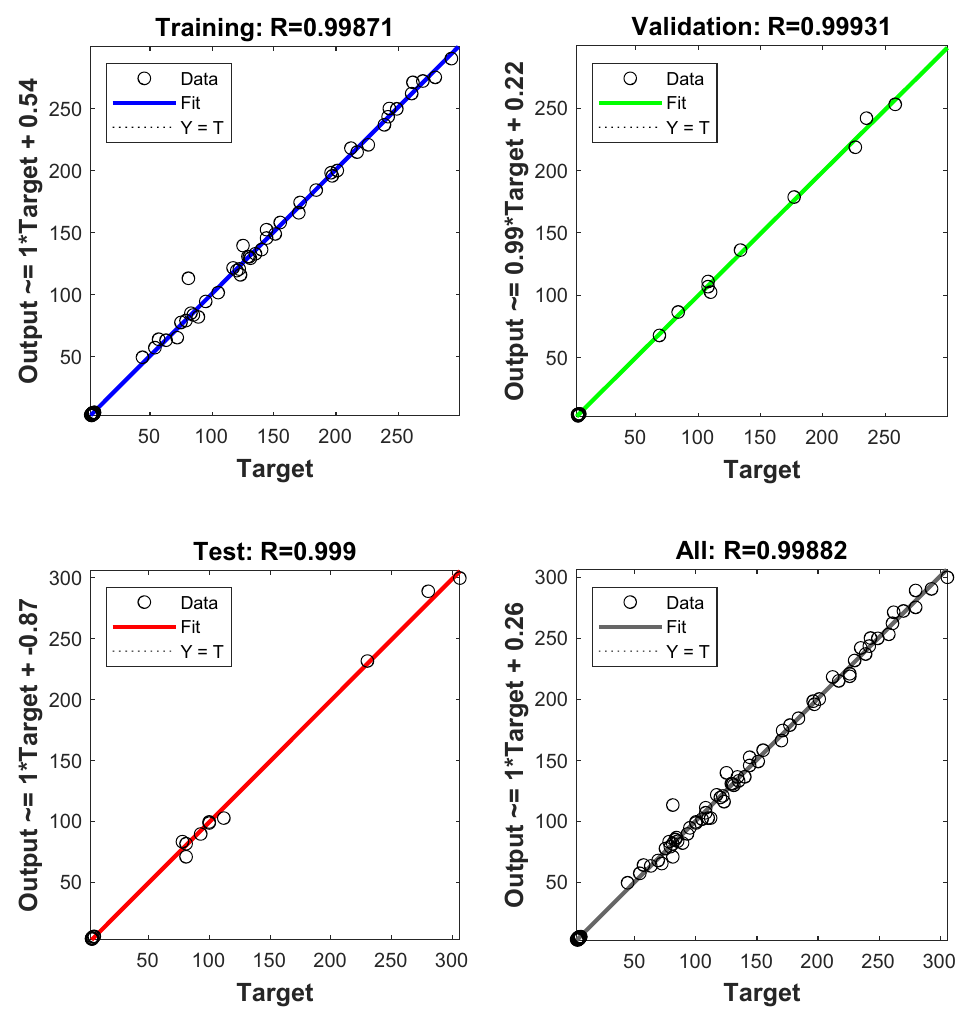
Figure 11: Regression model produced by the ANN model.